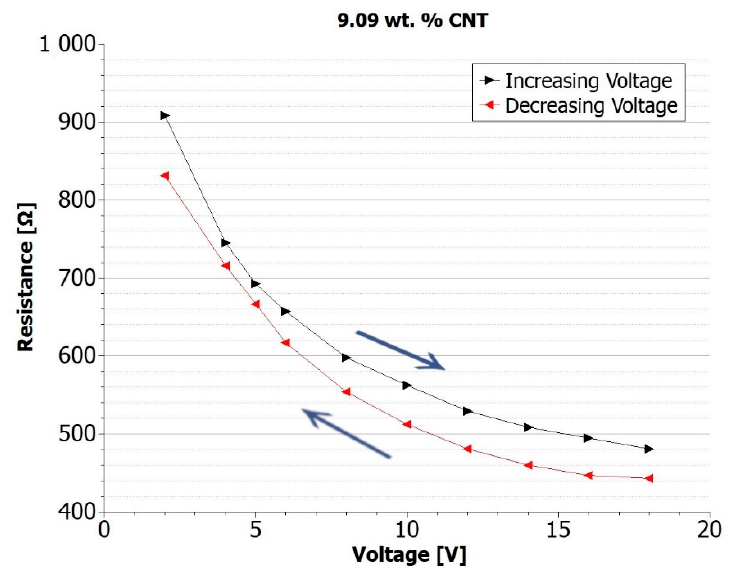
Figure 9. Electrical resistance values of conductive composite samples under different values of voltage applied and different schemes of I–V measurement (increasing and decreasing voltage load applied).